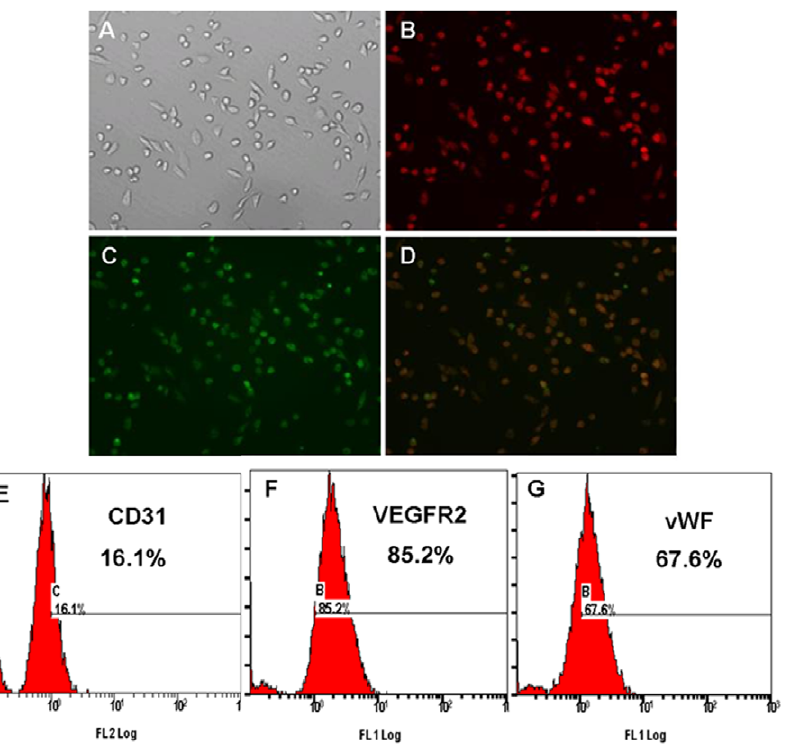
Figure 1. Immunofluorescence identification and immunophenotype of bone marrow derived-EPCs. The attached cells exhibited a spindle shaped, endothelial cells like morphology (A), and adherent cells DiLDL uptake (B: red, exciting wave-length 543 nm) and lectin binding (C: green, exciting wave-length 477 nm) were assessed under a fluorescence microscopy. Double positive cells appearing yellow in the overlay (D) were identified as differentiating EPCs ( 6 200). E to G, Membrane antigen expression on bone marrow-derived EPCs was determined by flow cytometry.